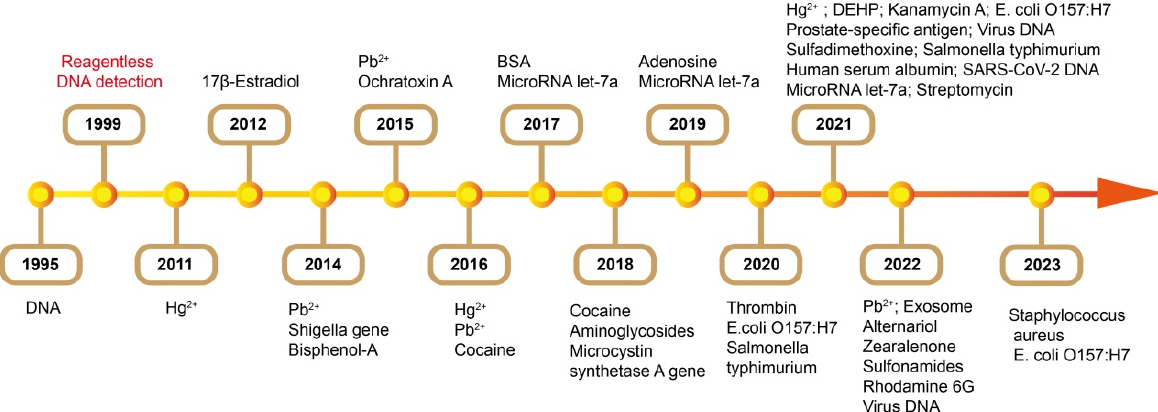
Figure 8. The major progress of FNA-FOEW sensors according to the target scope.